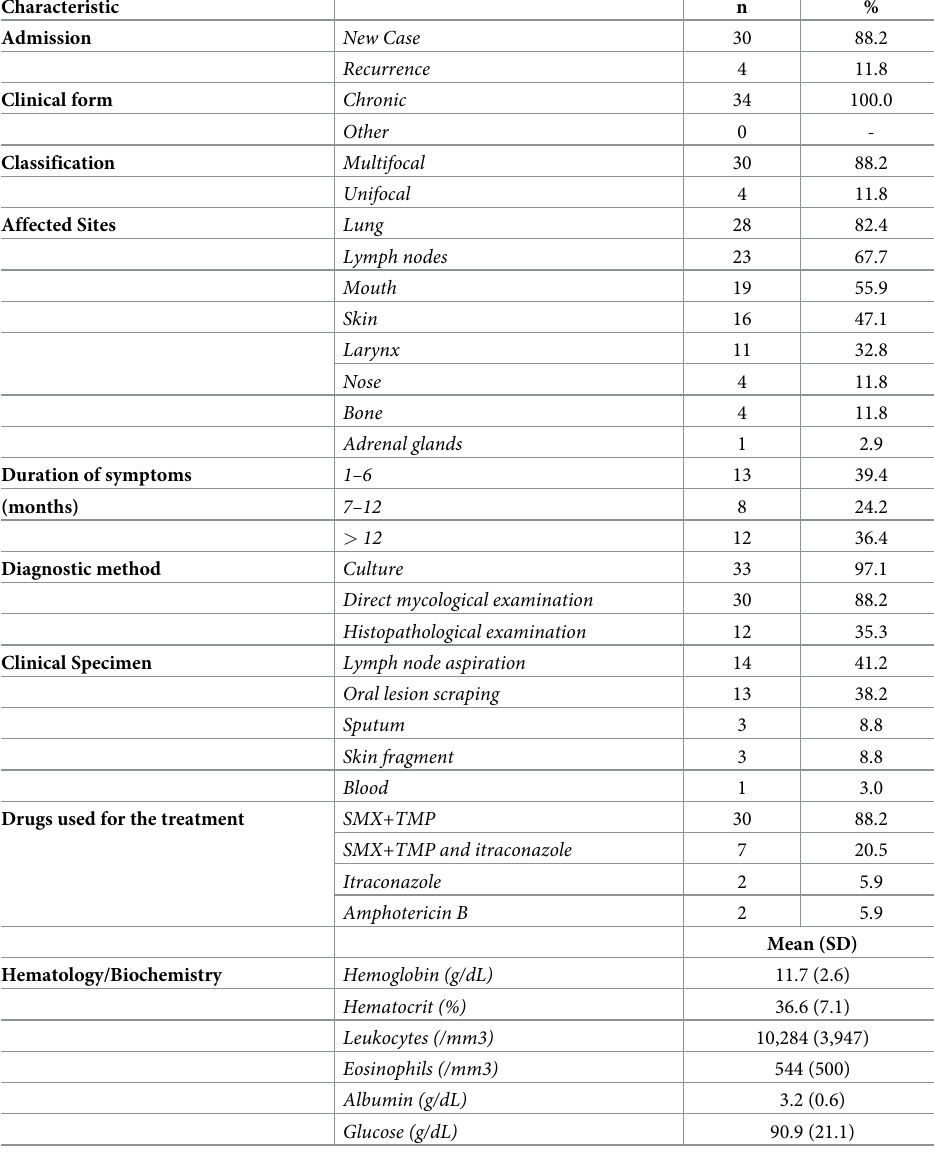
Table 2. Clinical and laboratory characteristics of patients with paracoccidioidomycosis caused by P . lutzii at the time of